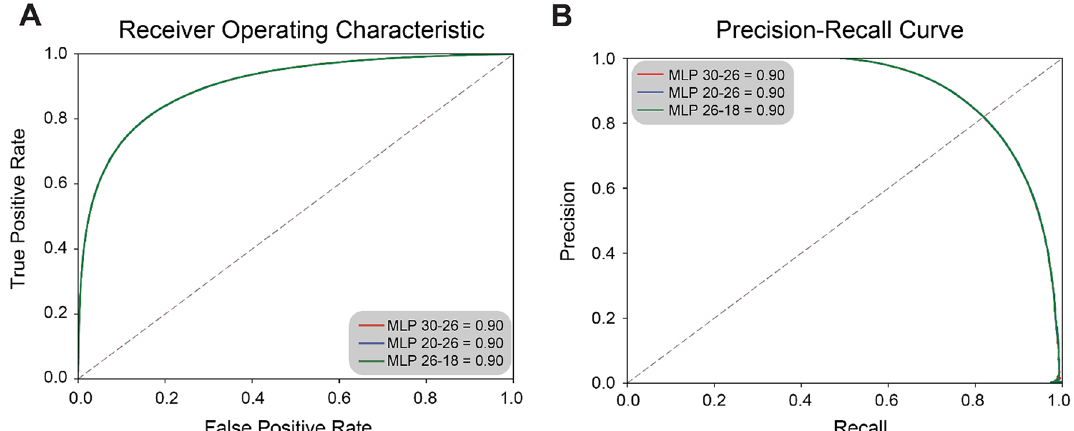
Figure 3. Predictive performances of the three candidate MLP models on FCD-HT cells. Both ( A ) ROC curve and ( B ) Precision-Recall curve showed that the three MLP models (MLP 20-26, MLP 26-18, and MLP 30-26) can predict the FCD-HT cells with relatively high precisions and recalls (precision: 0.83, recall: 0.80, accuracy: 0.82, and AUC: